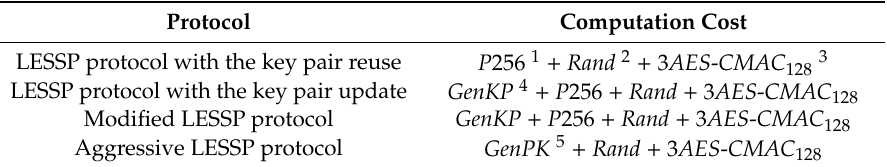
Table 3. Computation efficiency of pairing protocols.